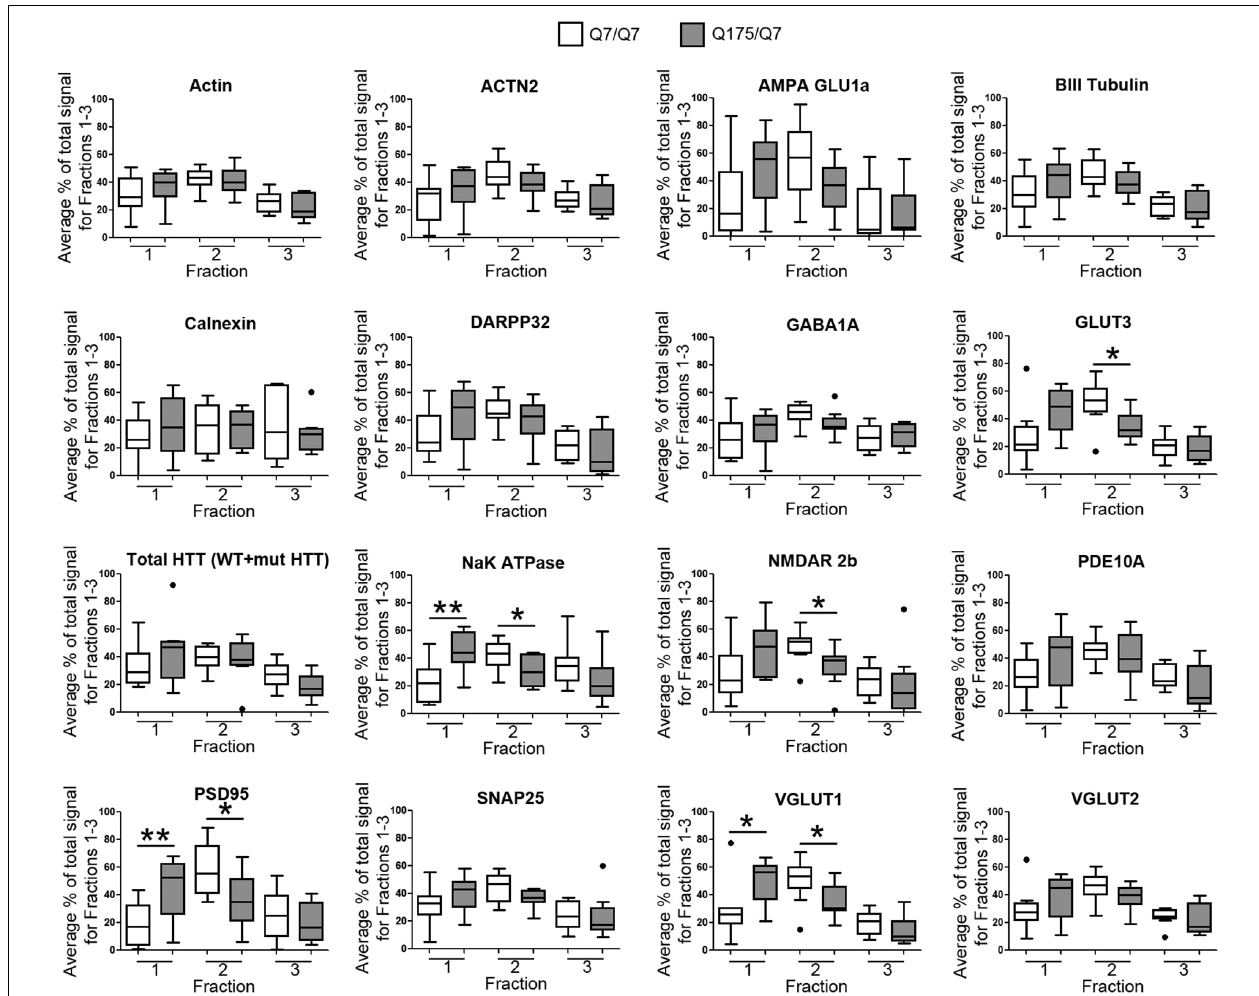
FIGURE 2 | GLUT3, VGLUT1, Na + /K + ATPase, NMDAR 2b, and PSD95 from 6-month old Q175/Q7 striata show altered distribution after fractionation compared to that of Q7/Q7 mouse striata. Equal volumes of fractions 1–3 from Figure 1 were run on large format SDS-PAGE gels and analyzed by western blot and ECL for proteins indicated. We performed both film and digital readouts for the many of proteins detected. We selected exposure times for quantification where the most intense signal among the fractions was not saturated. Signal for each fraction was standardized as a percentage of the total signal for all fractions and not based on absolute magnitude. Pixel intensity quantification was performed using ImageJ software (NIH) and graphed as percent of total signal summed for each protein in fractions 1–3 shown as a percentage of 100% Q7 or a percentage of Q175 100% ( N = 9 mice per group, * p < 0.05, ** p < 0.01, unpaired t -test). Graphs show Tukey-style box plots where the lower and upper hinges correspond to the first and third quartiles (the 25th and 75th percentiles) as described in section “Materials and Methods.” Data beyond the end of the whiskers are called “outlying” points and are plotted individually. The outlying values are included in the statistical analyses. Proteins with altered subcellular distribution include GLUT3, Na + /K + ATPase, NMDAR 2b, PSD95 and VGLUT1. See Supplementary Figure 2B for representative western blot